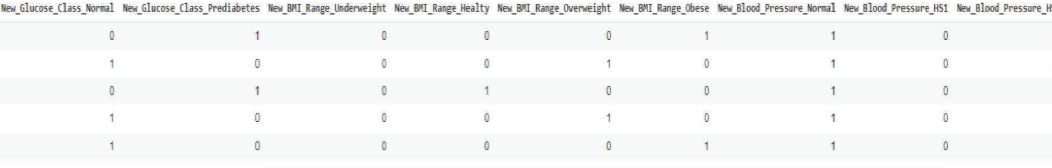
Figure 8: One hot encoding.